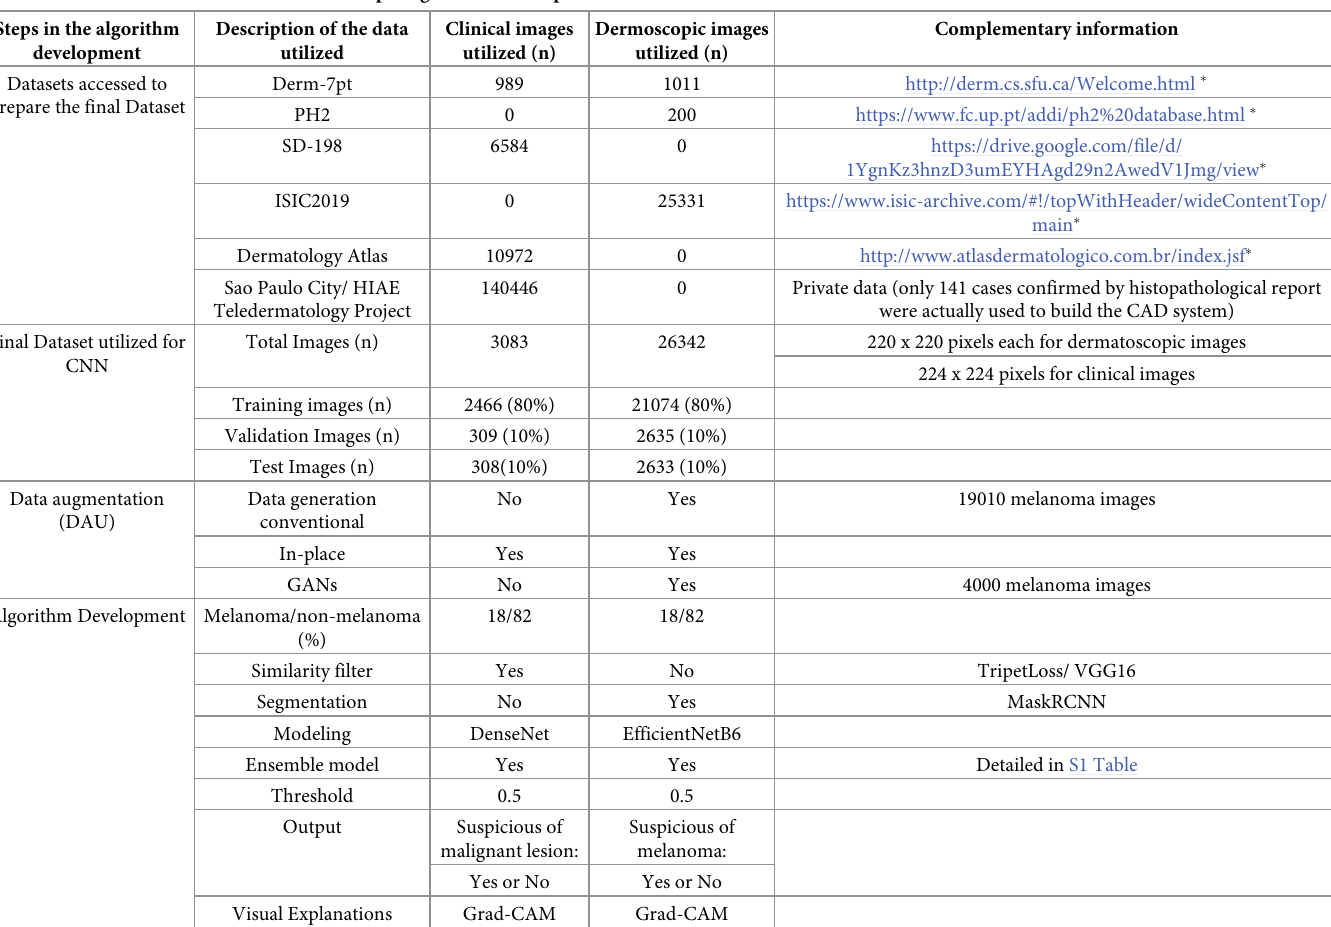
Table 1. General view of clinical and dermoscopic algorithms